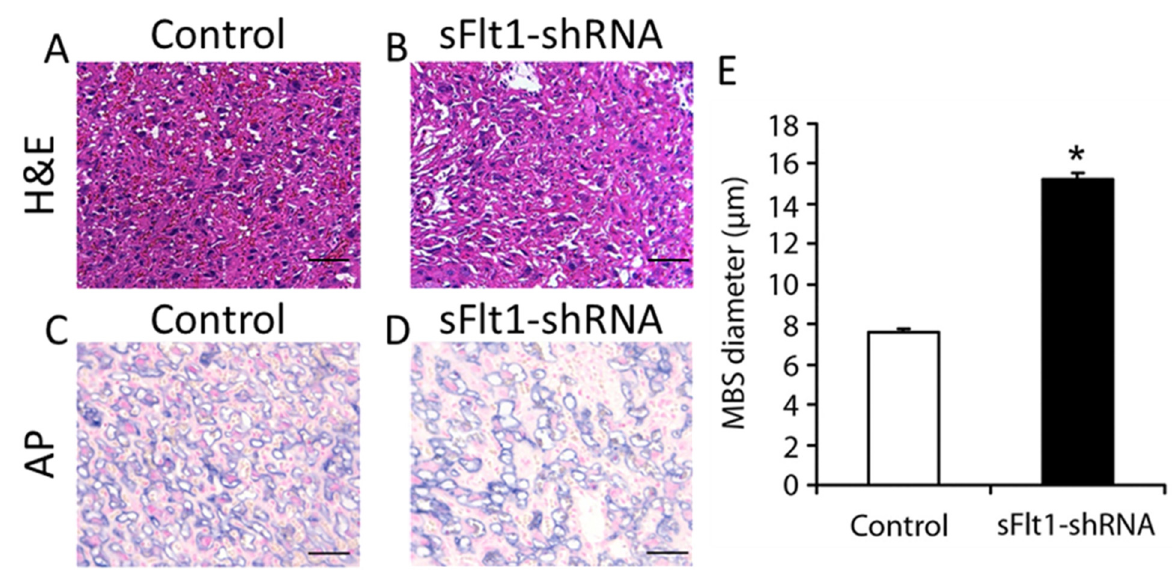
Figure 4. Expanded maternal sinusoidal blood spaces in the labyrinths of sFlt1-knockdown placentas. H&E-stained histological sections of placentas derived from placenta-specific sFlt1 knockdown dams showing severely dilated maternal blood spaces as compared to those in control placentas (A – B H&E). Alkaline phosphatase staining indicates the dilatation of maternal blood spaces in the placenta (C, D, AP). E, Maternal blood space (MBS) diameters. Mean MBS diameters in control placentas (white bar) and placentas derived from placenta-specific sFlt1 knockdown dams (black bar) at E17.5. Error bars indicate standard deviation. Asterisks (*) denote statistically significant differences between groups ( P < 0.05). n = 15 each for placentas taken from dams expressing copGFP alone (control) and those expressing sFlt1 shRNA plus copGFP (sFlt1-shRNA). Scale bar = 50 µm.